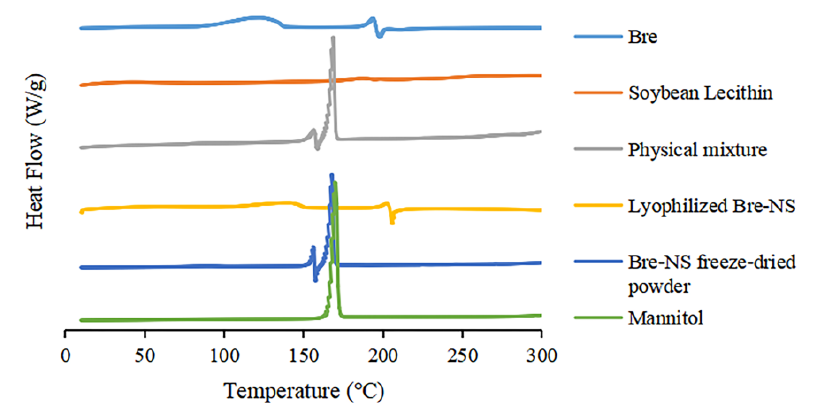
Figure 7. Differential scanning calorimetry (DSC) thermograms of Bre, soybean lecithin, the physical mixture, lyophilized Bre-NS, the Bre-NS freeze-dried powder and mixture, lyophilized Bre-NS, the Bre-NS freeze-dried powder and mannitol.